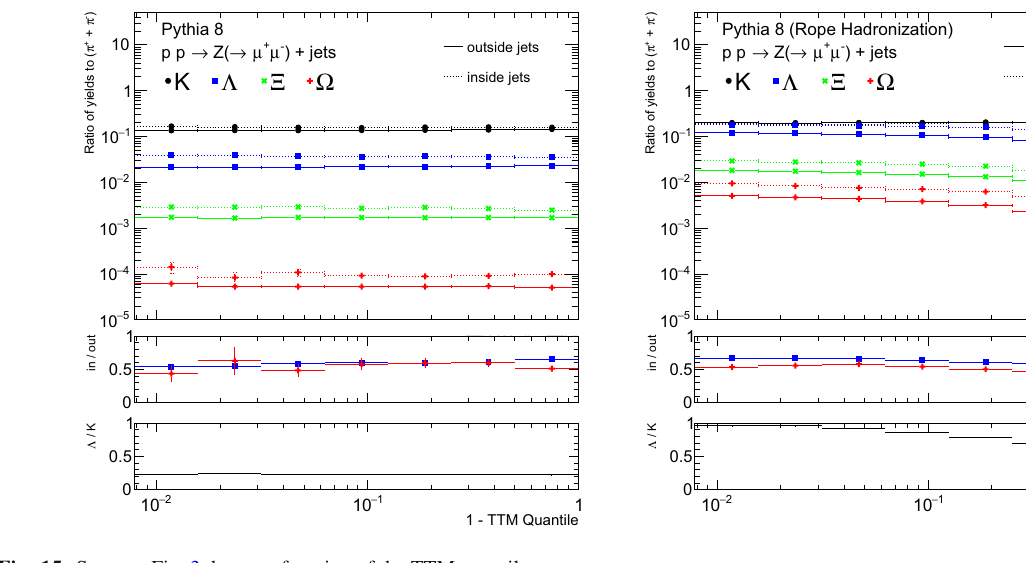
Fig. 15 Same as Fig. 3, but as a function of the TTM quantile